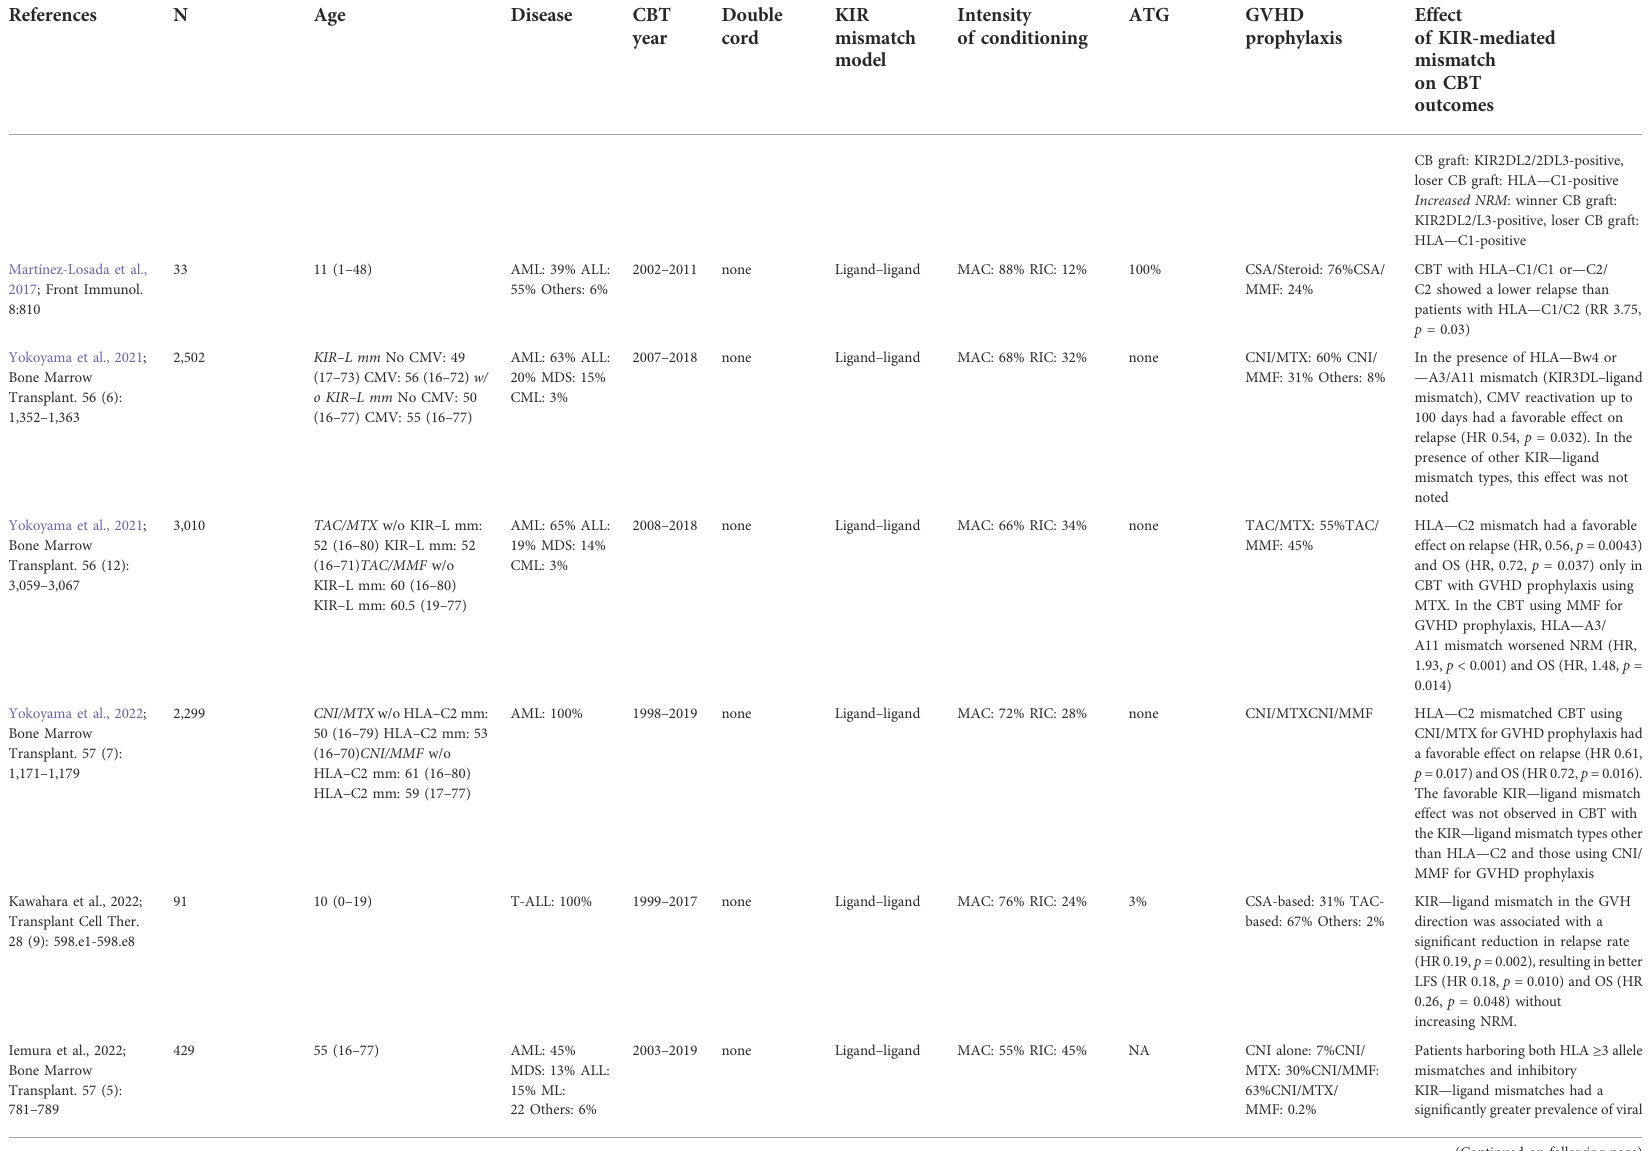
TABLE 2 ( Continued ) Cord blood transplantation (CBT) outcomes resulting from the KIR – ligand